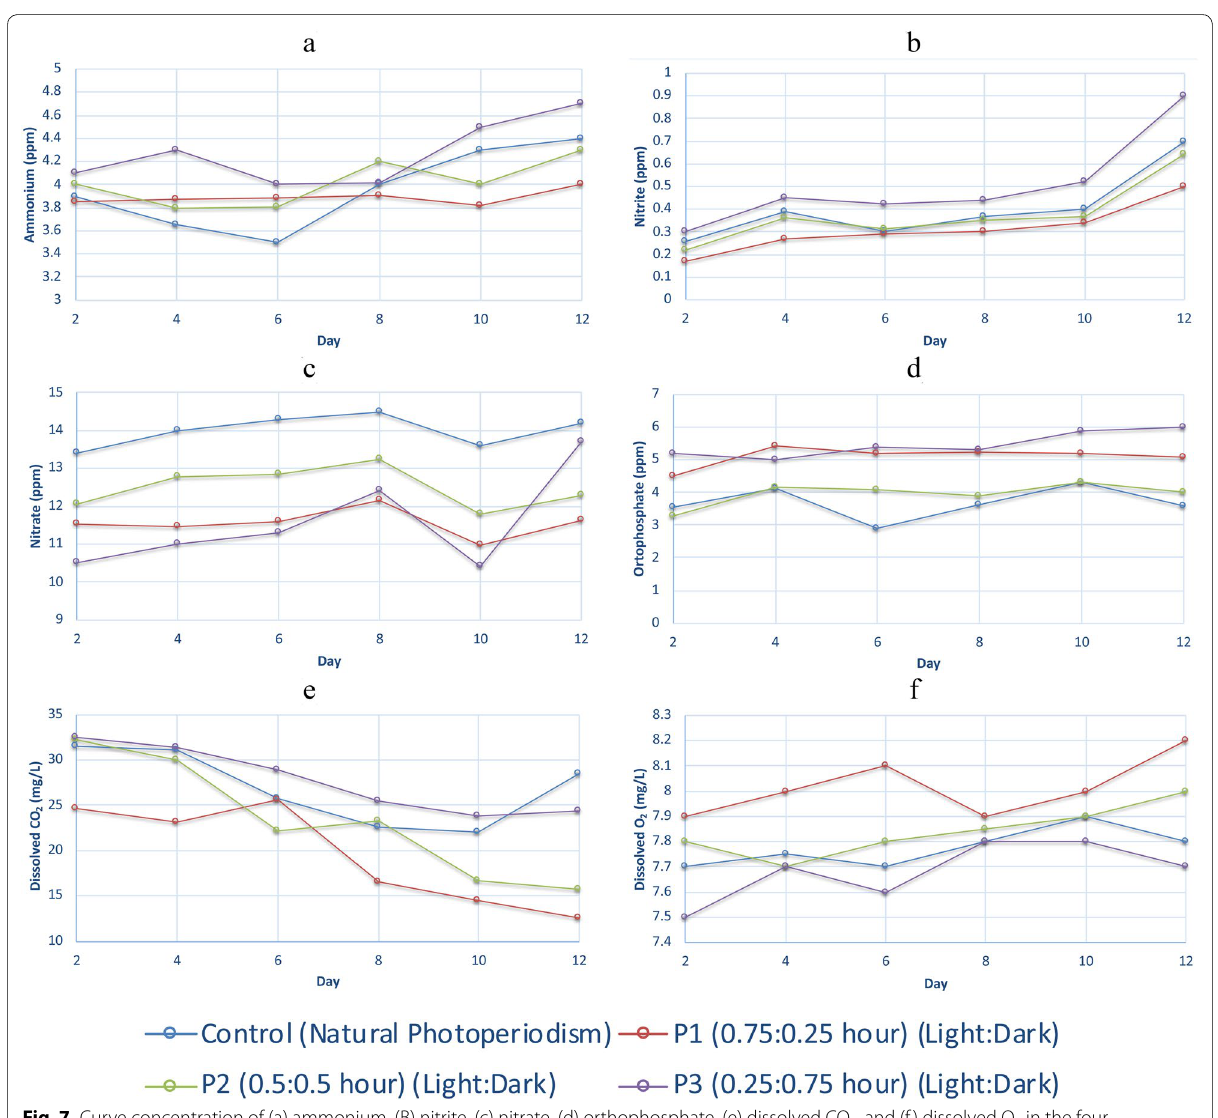
Fig. 7 Curve concentration of (a) ammonium, (B) nitrite, (c) nitrate, (d) orthophosphate, (e) dissolved CO 2 , and (f) dissolved O 2 in the four low-frequency flashing light